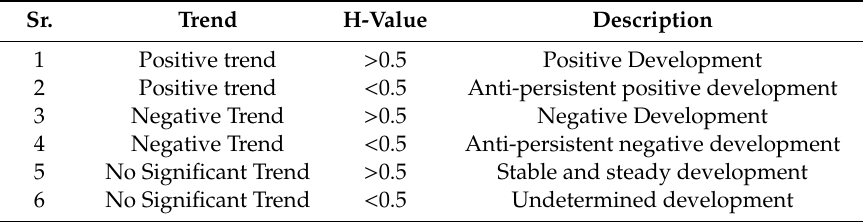
Table 1. Trends of future vegetation based on vegetation dynamics (2000–2017) and H value. Sr. Trend H-Value Description 1 Positive trend > 0.5 Positive Development 2 Positive trend < 0.5 Anti-persistent positive development 3 Negative Trend > 0.5 Negative Development 4 Negative Trend < 0.5 Anti-persistent negative development 5 No Significant Trend > 0.5 Stable and steady development 6 No Significant Trend < 0.5 Undetermined